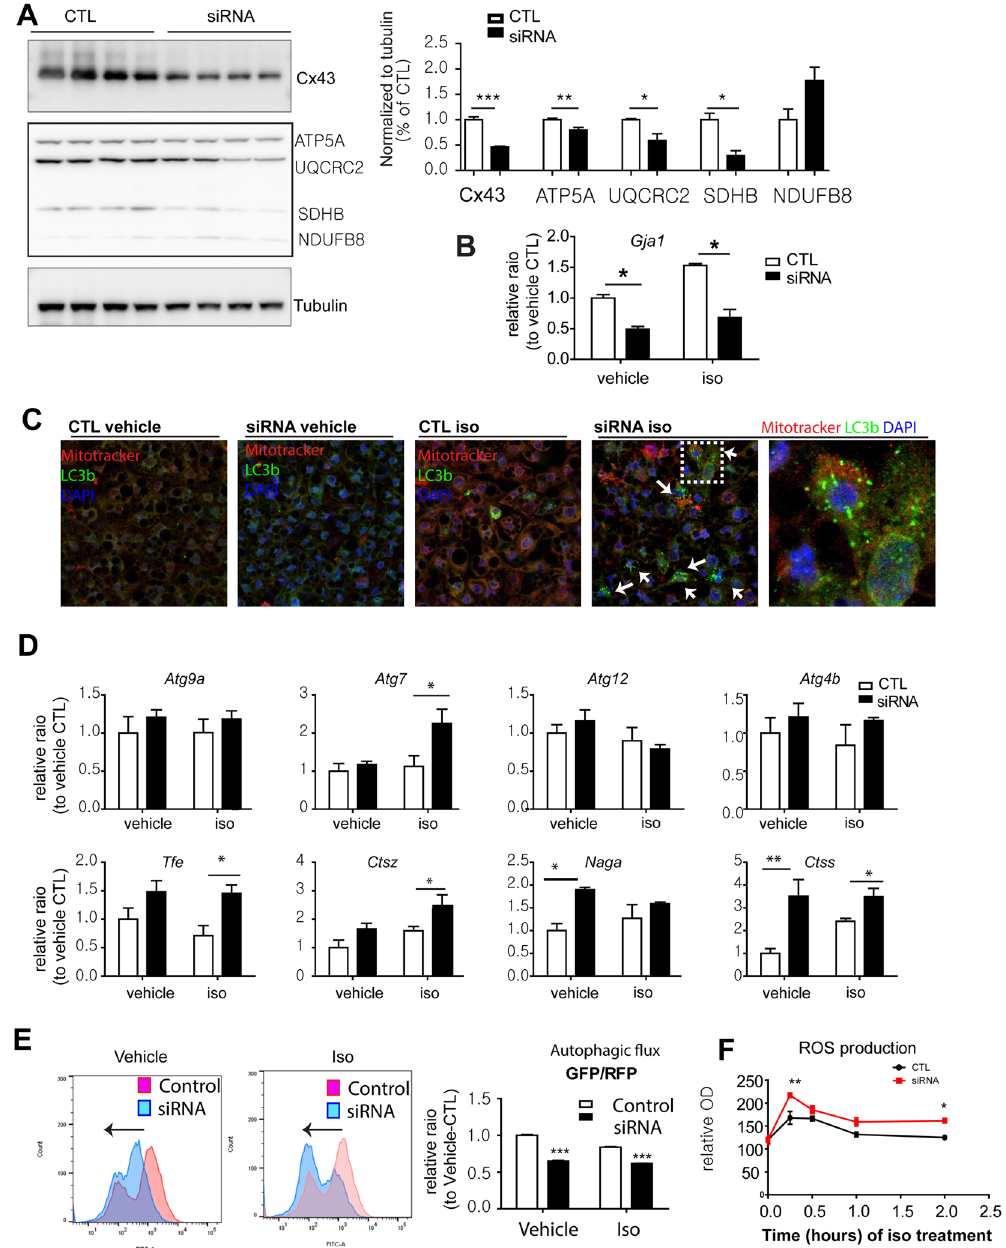
Figure 5. In vitro knockdown of Cx43 increases autophagy and PKA-dependent ROS generation. ( A–F ). Effect of knockdown of Cx43 in adipocytes differentiated from C3H10T1/2 cells treated with siRNA targeting Gja1 and scramble controls. ( A ) Immunoblot analysis of Cx43 and mitochondrial proteins involved in oxidative phosphorylation (mean ± SEM; t-test, n = 4, * p < 0.05, ** p < 0.01, *** p < 0.001). ( B ) qPCR analysis of Gja1 expression (mean ± SEM; t-test, n = 3, * p < 0.05). ( C ) Confocal microscopic images of LC3B and MitoTracker after 4hr of isoproterenol treatment (10 μ M). ( D ) qPCR analysis of expression of autophagy related genes. Two- way ANOVA revealed significant main effects of Gja1 expression in mRNA levels ( Atg9a : p = 0.0001, Atg7 : p = 0.0041, Atg4b : p = 0.017, Naga : p = 0.0001). Significant differences between controls and siRNA knockdown were determined by post-hoc pairwise comparison with Bonferroni correction (mean ± SEM; n = 4 per condition). ( E ) Flow cytometric analysis of autophagic flux in adipocytes differentiated from C3H10T1/2 cells overexpress eGFP-mCherry-LC3, transfected with siRNA targeting Gja or scramble control. The adipocytes were treated with isoproterenol or vehicle for 2hr before analysis. GFP/RFP ratio represents autophagic flux (mean ± SEM; t-test, n = 3, *** p < 0.001). ( F ) ROS generation during the course of isoproterenol treatment for up to 2 hr measured by H2-DCF fluorescence. (Immunoblots accompanied by size markers in Fig.